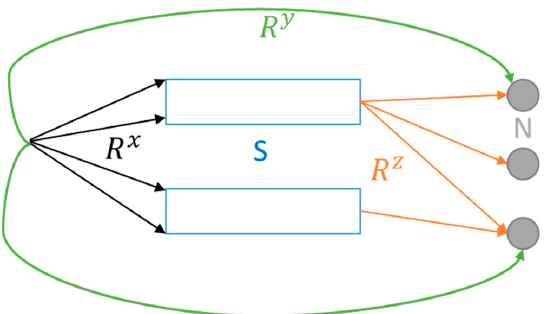
Figure 2. Schematic of the stockyard–port routes. R x are the routes from the unloading terminal to the stockyard ( S ). R y is the routes that start in the unloading terminal and reach the berths ( N ). R z links the stockyard to the berths.